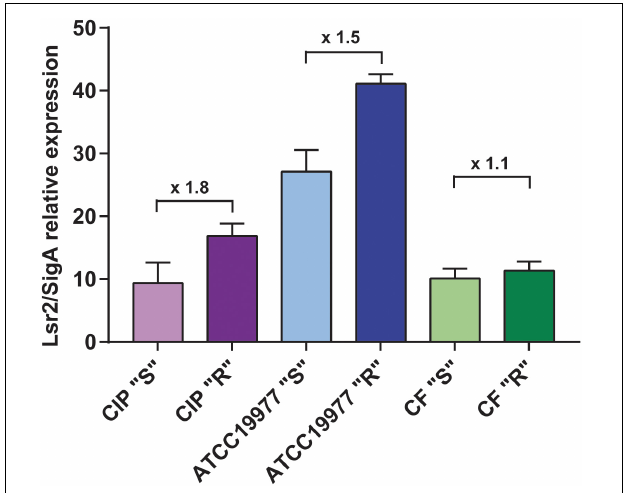
FIGURE 1 | Increased transcriptional expression of lsr2 in M. abscessus R variants. qRT-PCR results of lsr2 mRNA expression in the R and S variants of M. abscessus CIP104536 (Collection Institut Pasteur), ATCC19977 type strains and in the CF clinical isolate. Results are expressed as lsr2/sigA ratio as described in Pawlik et al. (2013). For each assay, n = 3 and error bars are SEM.